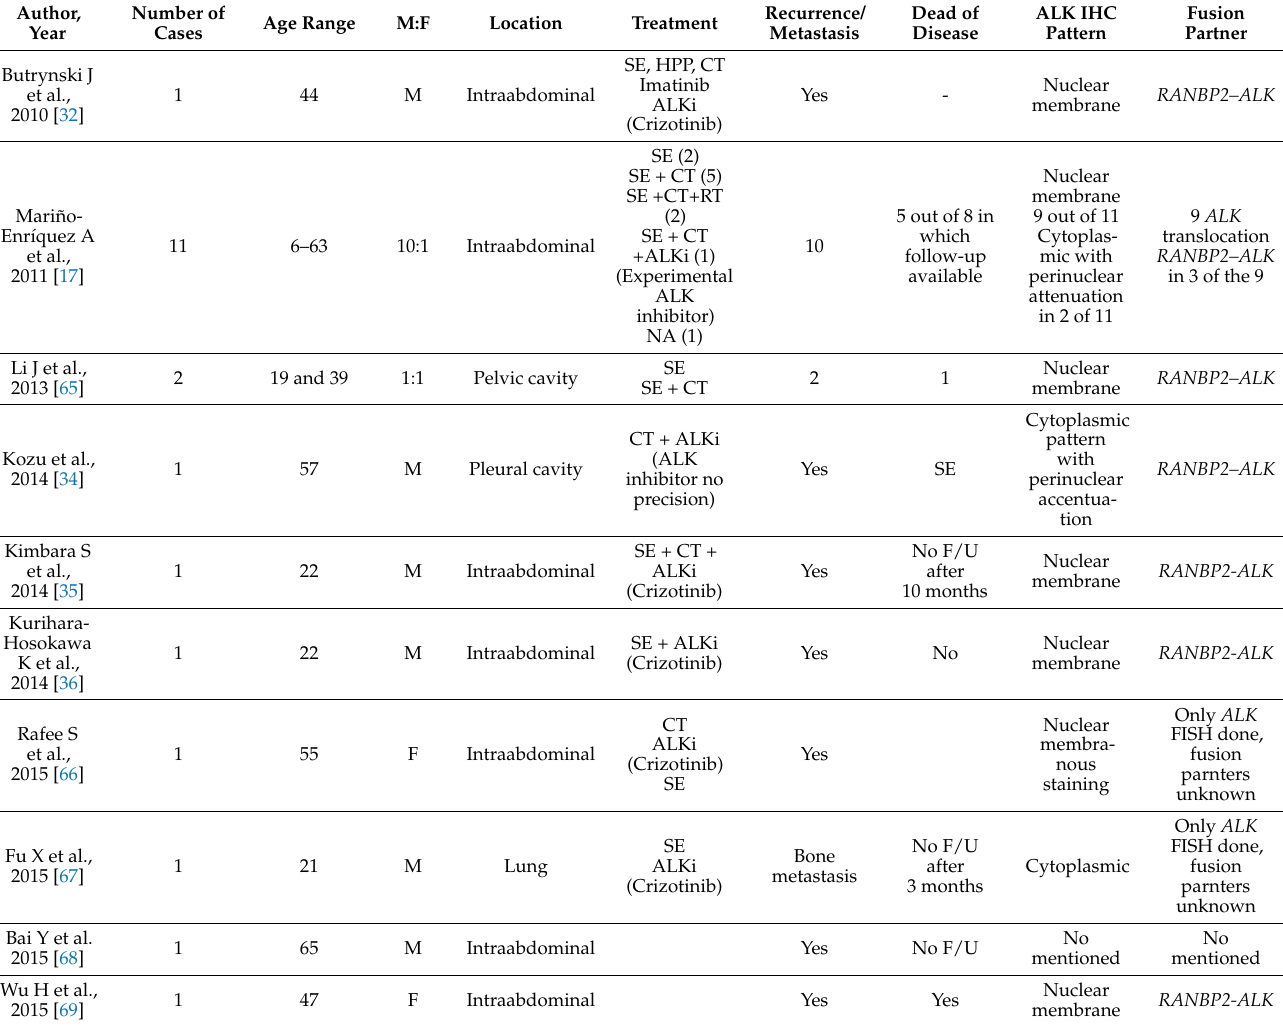
Table 1. Clinical and pathological features of the reported cases of epithelioid inflammatory myofi- broblastic